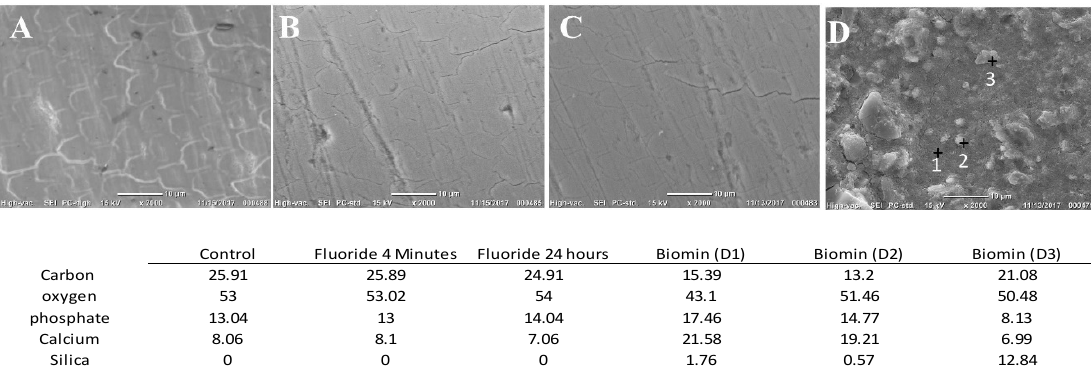
Figure 5. Top surface examination by SEM/EDS for the four groups. (Control) group ( A ), the (fluoride 4 min) ( B ), and the (Fluoride-24 h) ( C ) show the boundaries of the enamel prisms. Biomin group ( D ) shows the formation of a newly formed layer having crystal like structures and silica particles. The table shows the mass percentages of each element detected by EDS in each group.